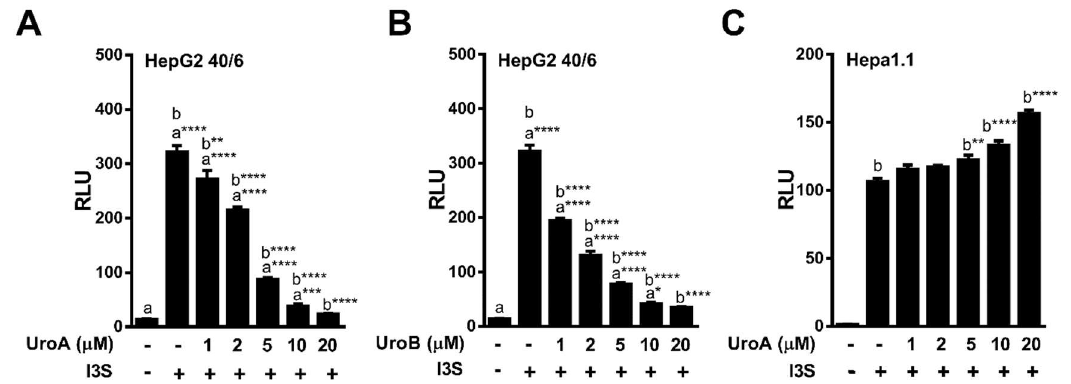
Figure 6. Dose-response antagonism of I3S mediated AHR transcriptional activity by UroA and UroB. ( A , B ) HepG2 (40/6) or ( C ) Hepa1.1 reporter cells were treated for 4 h with 10 nM I3S and indicated doses of UroA or UroB. Cells were lysed, and luciferase activity was measured. Data are presented as mean +/−S.E.M., n = 3; significance was determined by one-way ANOVA, p -value ≤ 0.05 (*), p -value ≤ 0.01 (**), p -value ≤ 0.001 (***) or p -value ≤ 0.001 (***).